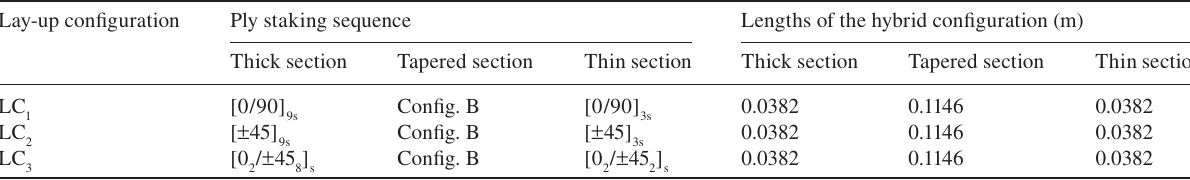
Table 3 List of lay-up confi gurations. Lay-up confi guration